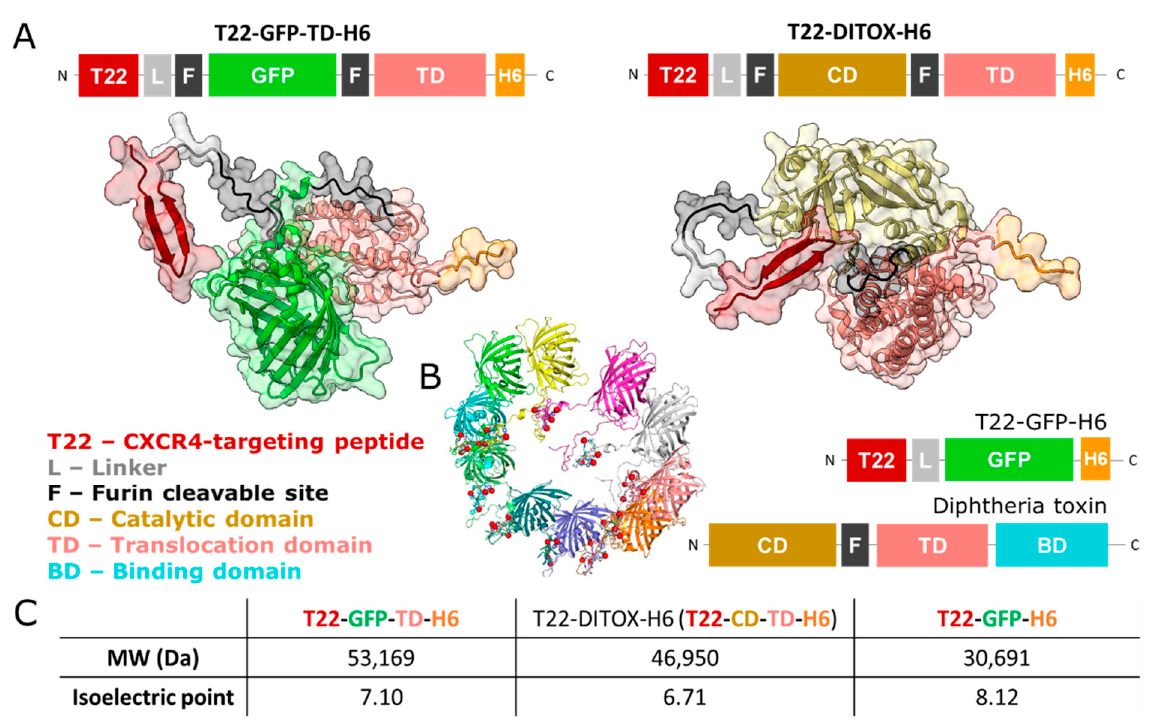
Figure 1. Modular organization of T22-empowered proteins. ( A ) Modular disposition and 3D models of T22-GFP-TD-H6 and T22-DITOX-H6. T22-GFP-TD-H6 was engineered to mimic the CXCR4-targeted toxin T22-DITOX-H6 through the replacement of the catalytic domain of the toxin (CD) by the green fluorescent protein (GFP). The translocation domain (TD) was maintained. Both proteins display, from the N to the C terminus, the CXCR4 ligand T22, a flexible linker (L; GGSSRSS), two furin cleavable sites (F; GNRVRRSV) recruited from the original DT, and the hexa-histidine tag (H6), all represented in color code. Furin cleavable sites have proved to be functional in this family of modular constructions [48]. Models in 3D were predicted in AlphaFold2 and represented with ChimeraX. ( B ) The modular disposition of the DT and T22 ‐ GFP ‐ H6 are also shown as references. In the center is the T22 ‐ GFP ‐ H6 nanoparticle as previously modelled [49], with each monomer represented in a different color and the stabilizing divalent cations as red spheres (reprinted from [49] with permission from Elsevier). ( C ) Molecular weight and isoelectric point of the three proteins used in this study, predicted by ProtParam (Expasy, http://web.expasy.org/protparam; accessed on 20 November